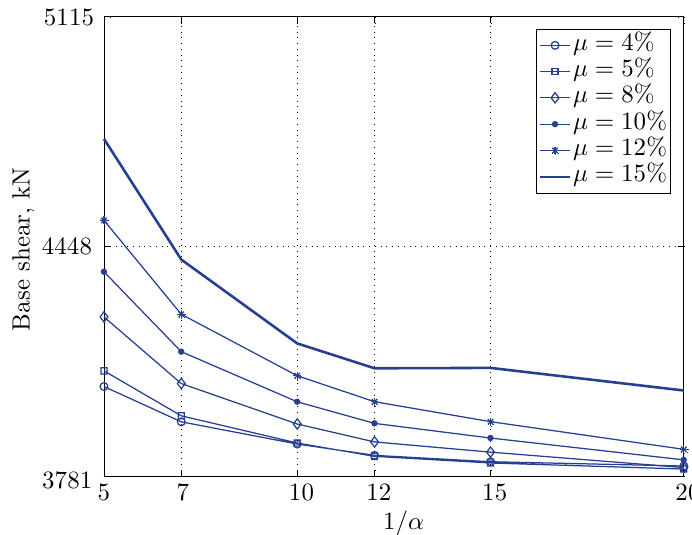
Figure 31. Maximum base shear for various isolation system parameters (Newhall).